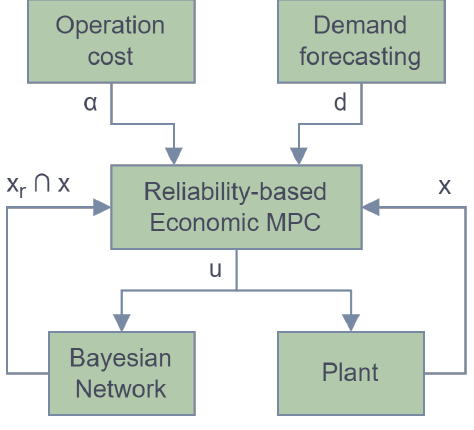
Figure 4. Control scheme.